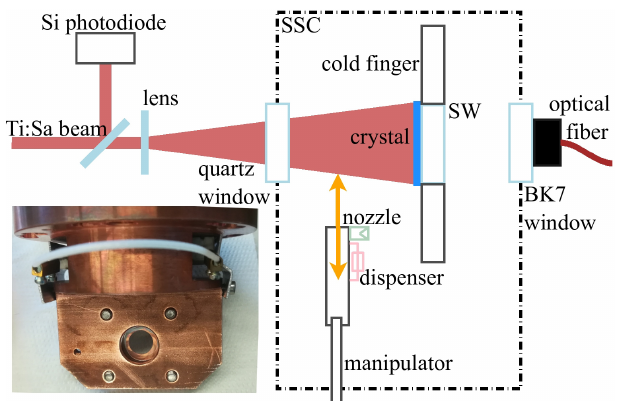
Figure 2. Sketch of experimental setup. The inset shows a picture of the cold finger with the sapphire window placed at its